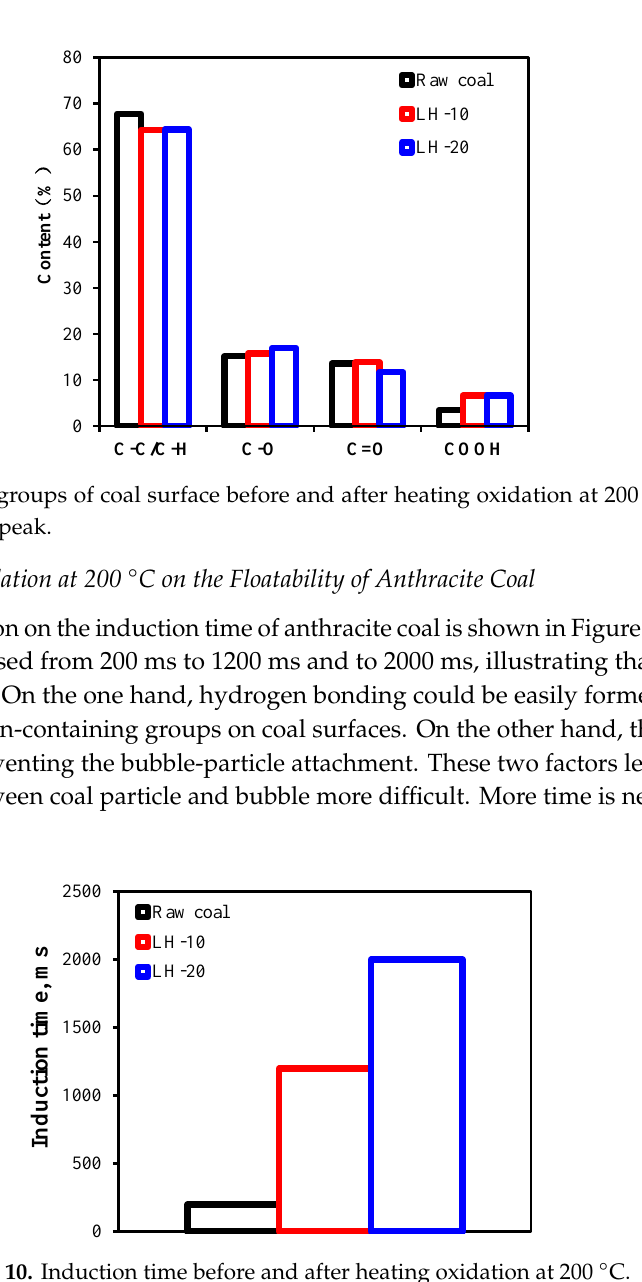
Figure 10. Induction time before and after heating oxidation at 200 °C.